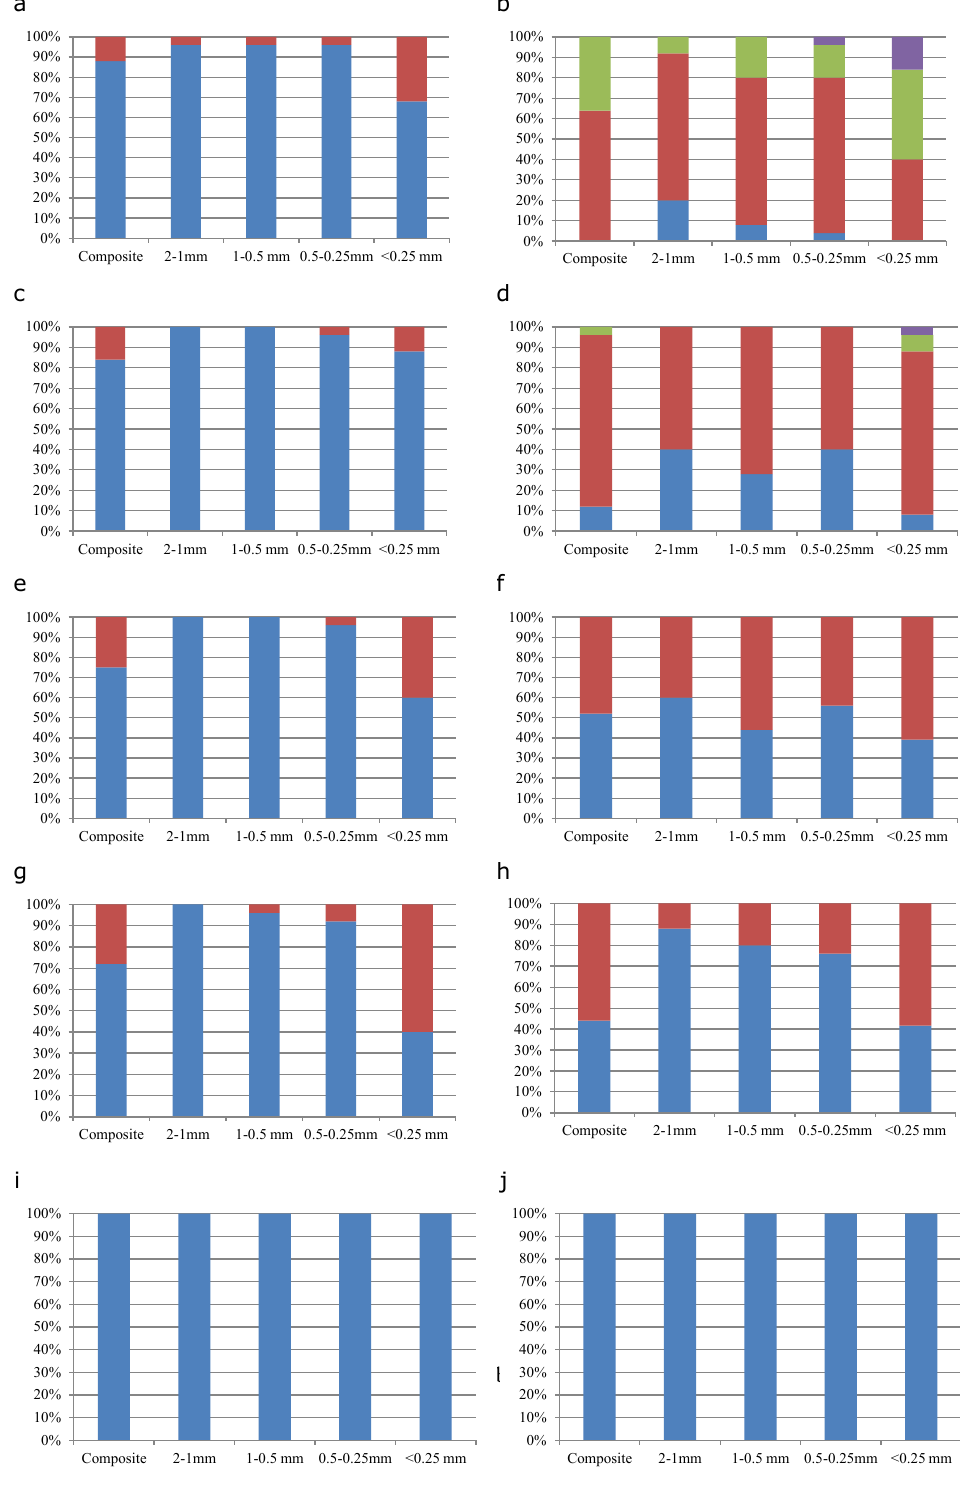
Fig. 4. Relative frequency of SWR for composite and sieved soil fractions, (a) unburned, after the fire; (b) burned, after the fire; (c) unburned, 2months after the fire; (d) burned, 2months after the fire; (e) unburned, 5months after the fire; (f) burned, 5months after the fire; (g) unburned, 7months after the fire; (h) burned, 7months after the fire; (i) unburned, 9months after the fire; and (j) burned, 9months after the fire.